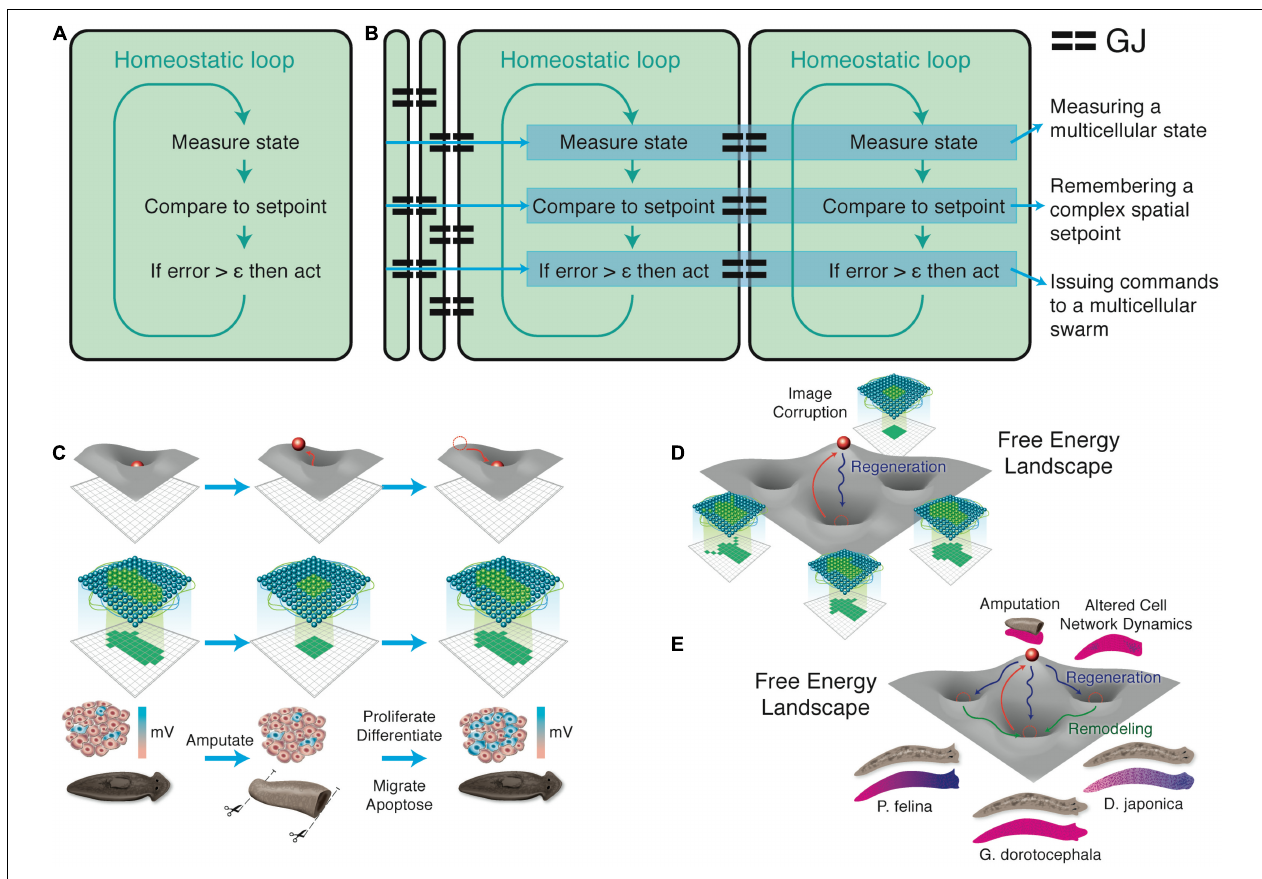
FIGURE 10 | Gap junctions scale homeostatic goals. Gap junctions are a type of connection architecture that facilitates scaling of goal states (and thus expands the cognitive cone of cellular agents). A single cell’s homeostatic cycle has 3 parts: measurements, comparison to a stored setpoint, and acting via effectors to stay in or reach the correct region of state space (A) . When coupled into gap junctions (B) , each of these 3 components expands in size and complexity: the cell group is able to (1) measure a larger region (reacting to spatially more complex inputs, not just local conditions), (2) store a more complex setpoint pattern, and (3) act (deform, grow, etc.) at a scale that produces large-scale anatomical change. The goals of such networks readily map on to regeneration and regulative development (C) : dynamical systems pictures of artificial neural networks as they perform pattern completion based on partial input illustrate an energy landscape with wells corresponding to stable target morphology memories. The process of completing a correct planarian pattern from a simple fragment can be modeled in this way, perhaps with overall stress levels instantiating the free energy that the system is trying to minimize (Kuchling et al., 2020b). Such attractors correspond to different possible morphologies, and indeed the normally robust regeneration toward a single pattern (D) can be modified in planaria by temporarily disrupting their gap junctional network, which causes genetically un-modified worms to nevertheless build heads appropriate to other species’ attractors in morphospace